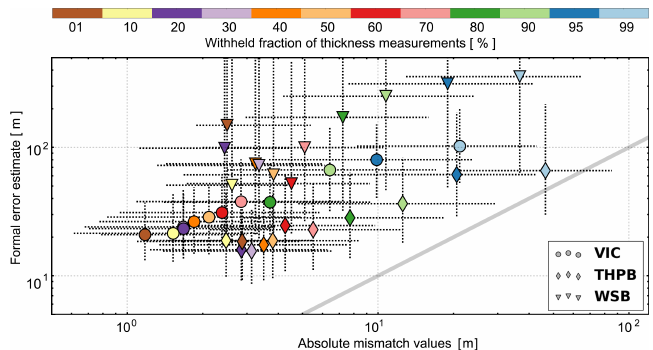
Figure 7. Median values for the absolute thickness mismatches and the error estimates at measurement locations not included during the reconstruction. Marker colours indicate the respective fraction of all measurements withheld from the reconstruction. Dashed crosses span the interquartile range of all mismatch values (horizontal) and all formal error estimates (vertical). For orientation, the identity line was added in